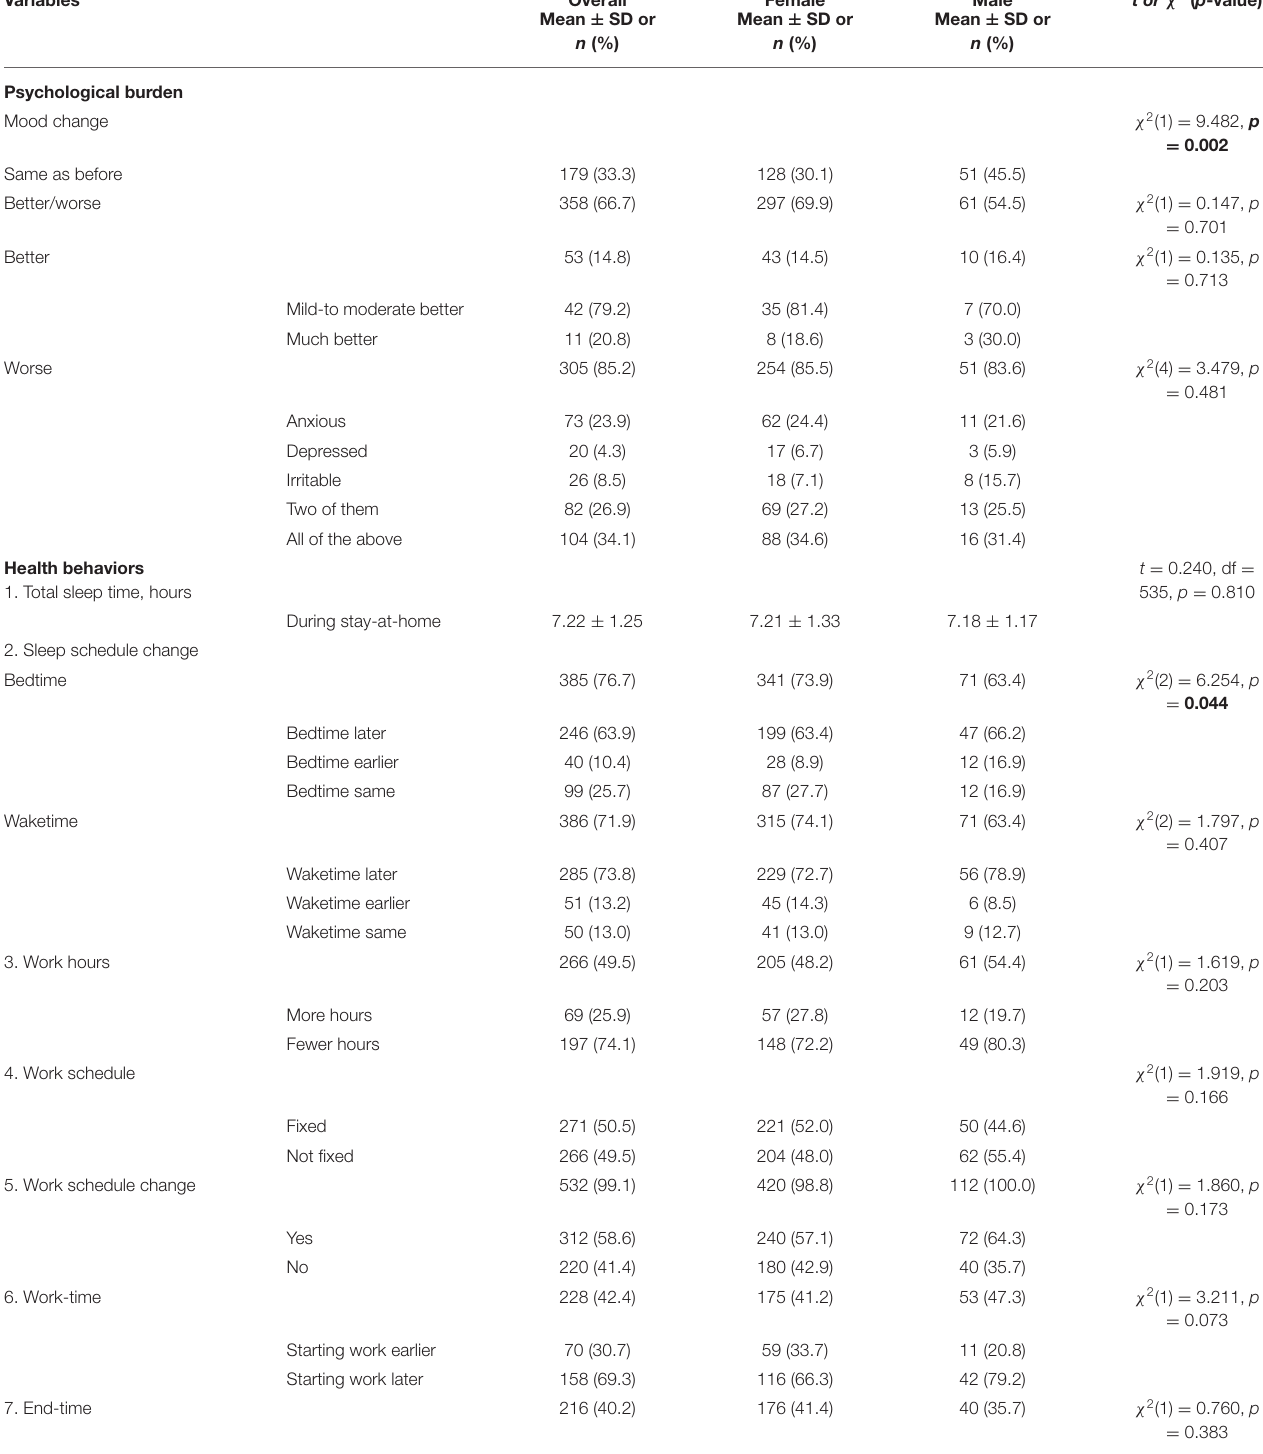
TABLE 2 | Sex differences in psychological burden and health behaviors of healthcare workers during the COVID-19 stay-at-home orders.